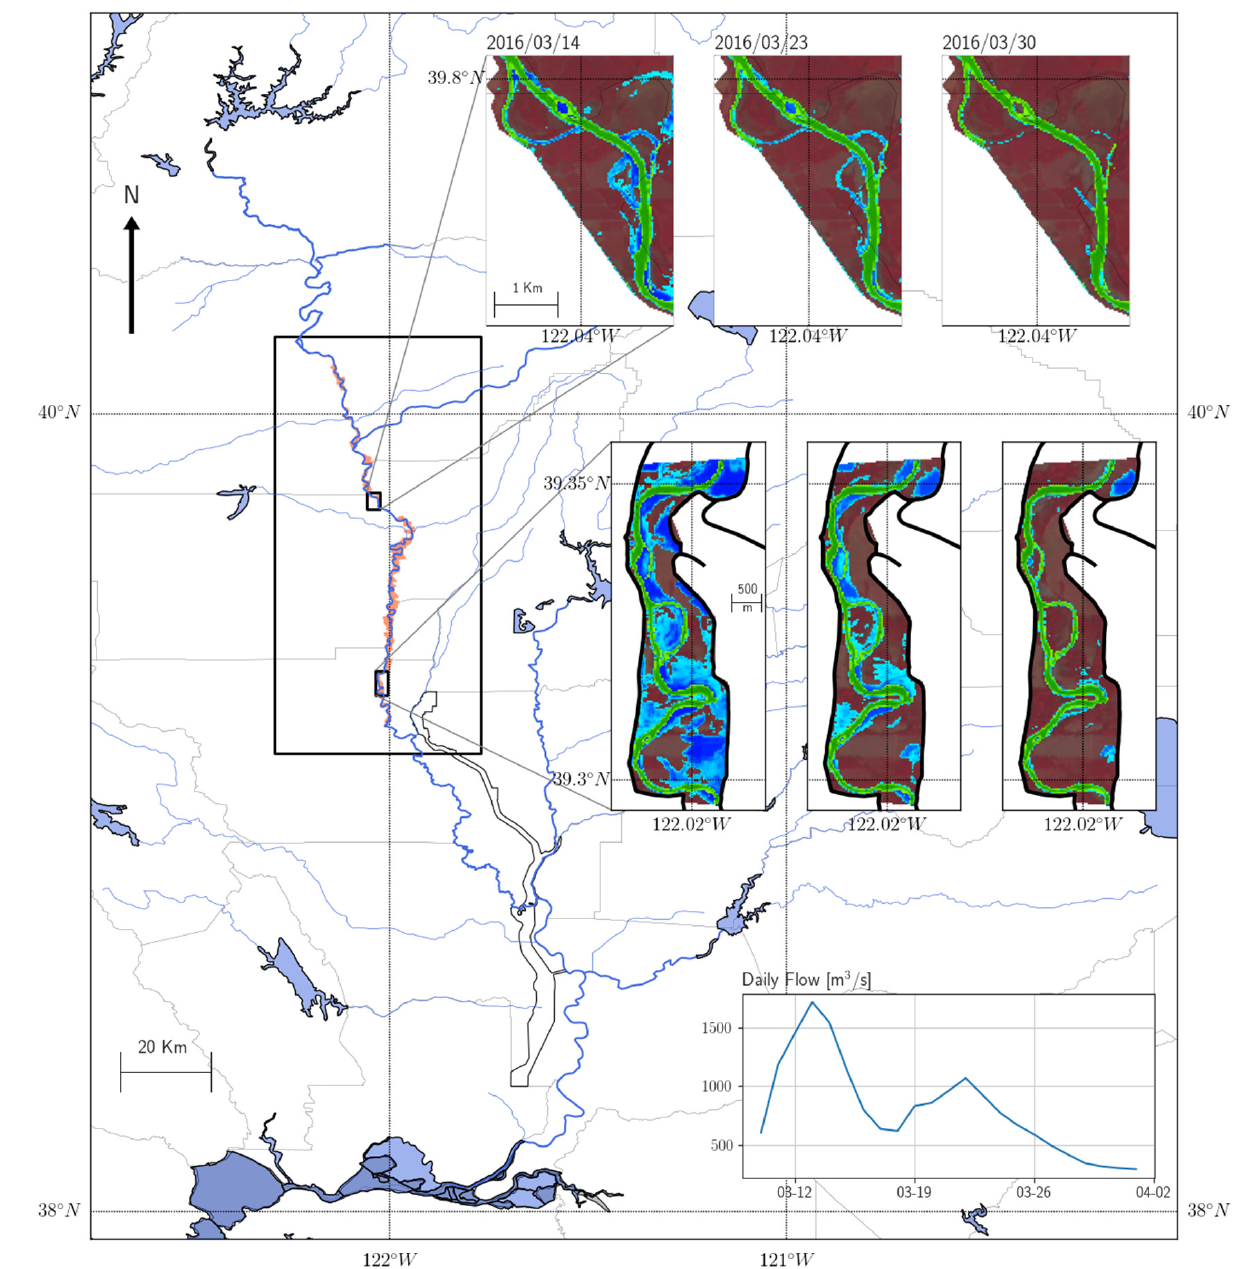
Figure 9. Off-channel inundated areas after 13 March 2016 storm event (hydrograph at bottom right corner) at two specific locations along the study area (black rectangle), extracted from LandSat-8 images using mNDWI with a single threshold (mNDWI > −